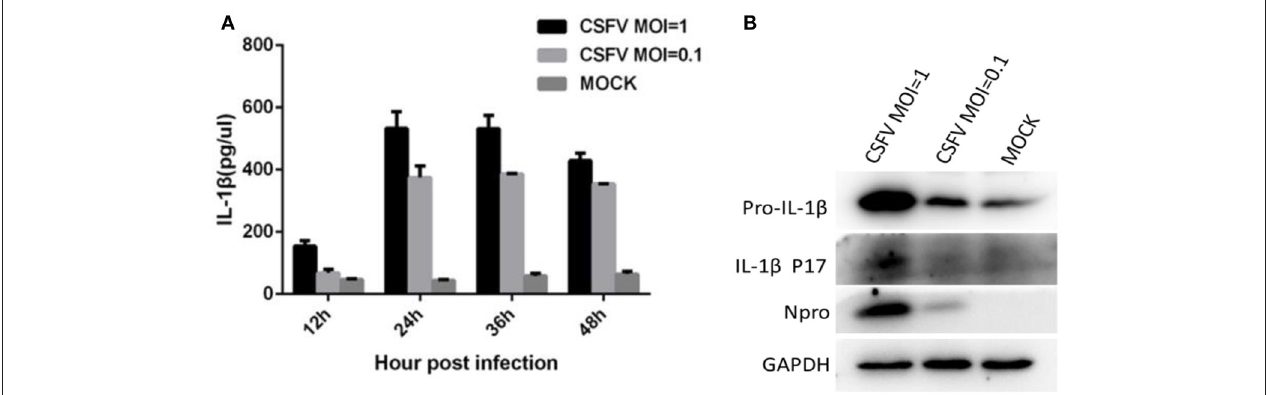
FIGURE 1 | CSFV infection induced the maturation and secretion of IL-1 β . (A) PBMCs were mock treated or infected with CSFV at a MOI of 1 or 0.1 for different lengths of time. The secretion of IL-1 β was detected using an IL-1 β -specific ELISA kit at different time points. (B) The expression of pro-IL-1 β and the subunit p17 were identified by western blot analysis of cell lysates following CSFV infection (MOI of 1 or 0.1) at 24h pi. Npro protein was detected by western blotting using an anti-CSFV Npro antibody for confirmation of CSFV infection. GAPDH was used as an internal loading control.